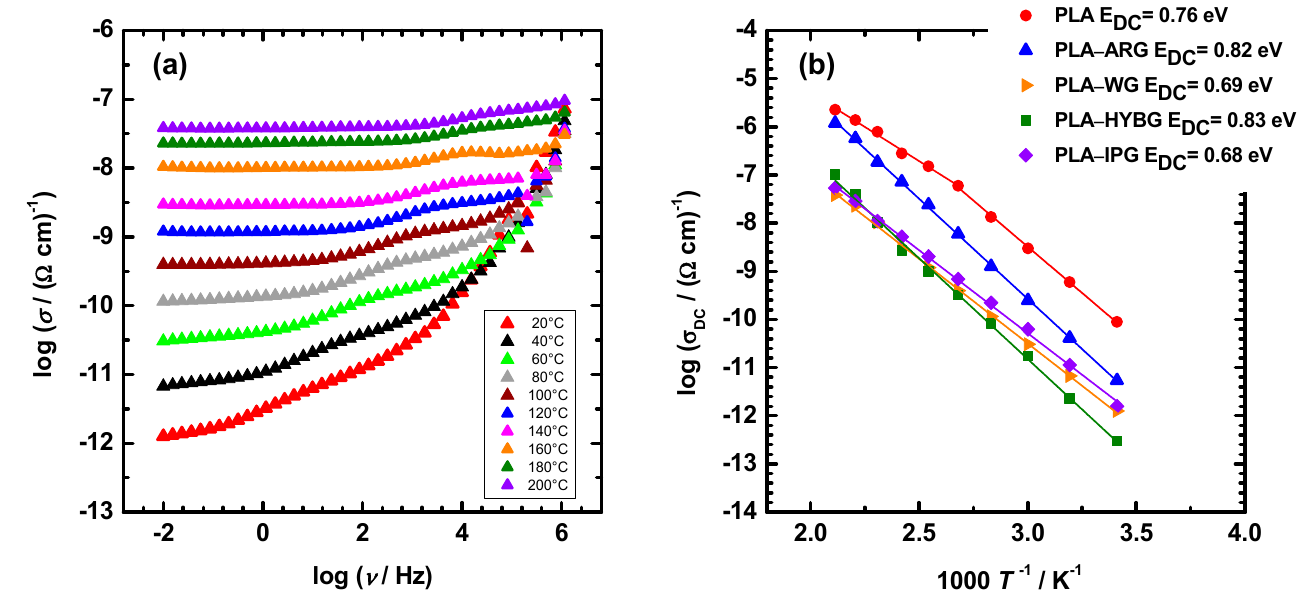
Figure 5. ( a ) Conductivity spectra at different temperatures for PLA–WG composite and ( b ) Arrhenius plot of DC conductivity for all composites.